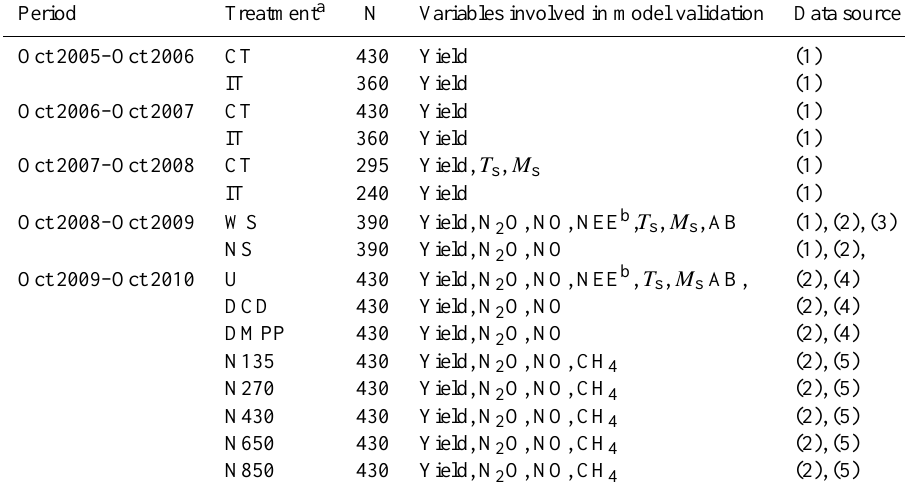
Table 1. Details of observational cases with different management practices used for model